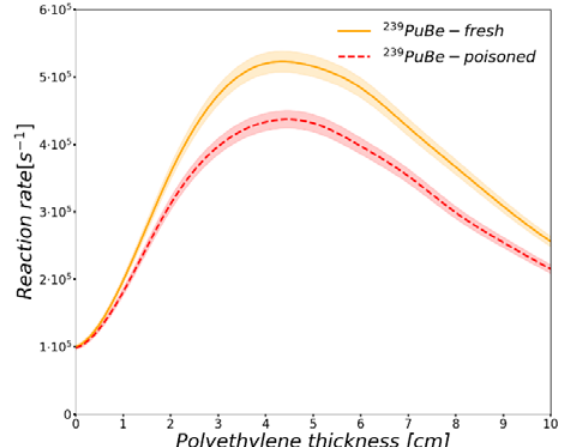
Fig. 5 – Comparison of reaction rates in fission chamber through irradiated and nonirradiated beryllium, using SbBe and PuBe neutron source with 3% uncertainty marked, calculated in SERPENT2